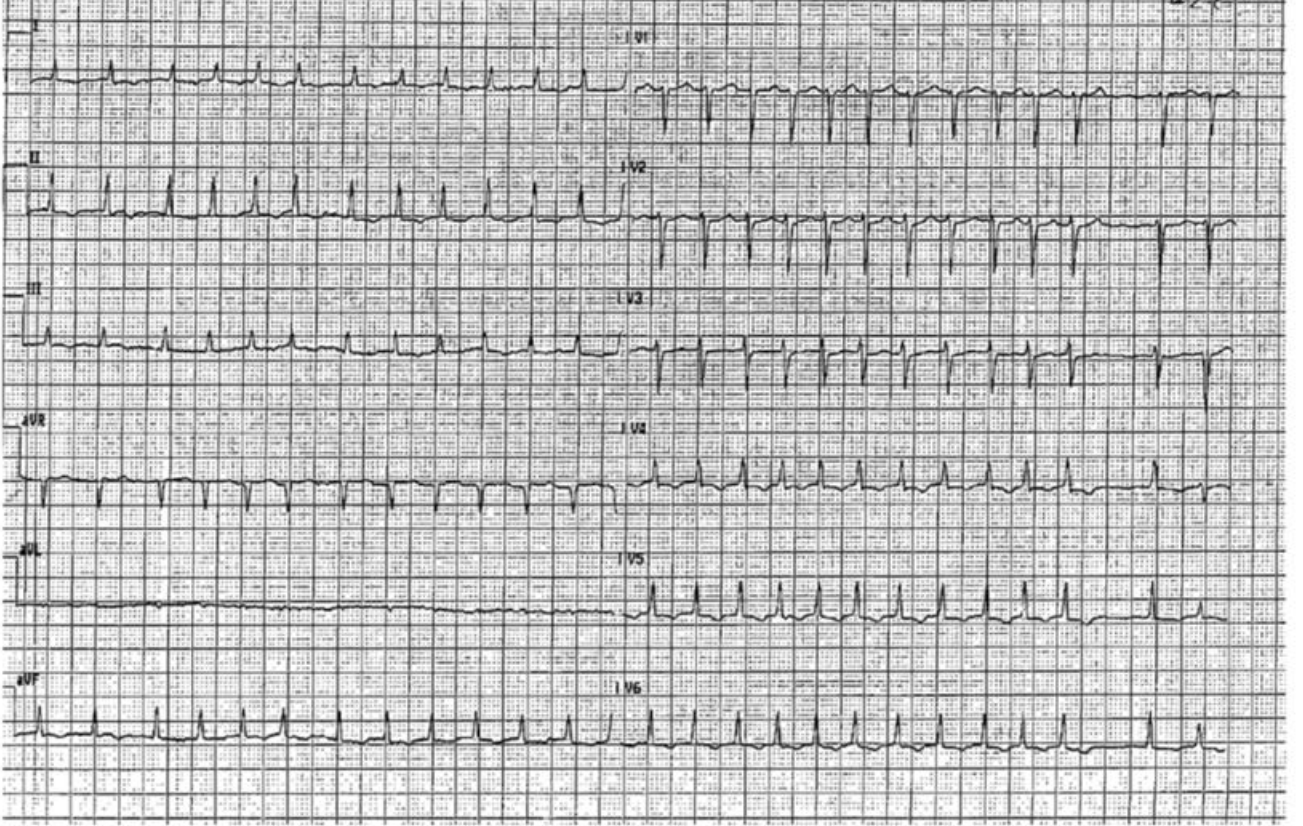
Figure 1. EKG at admission.